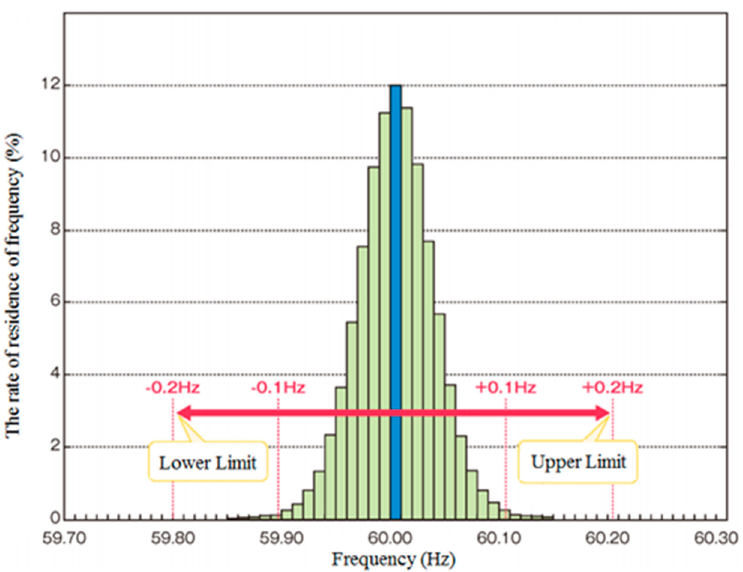
Figure 2. Frequency distribution. Reproduced with permission from [32]. IEEE, 2016.